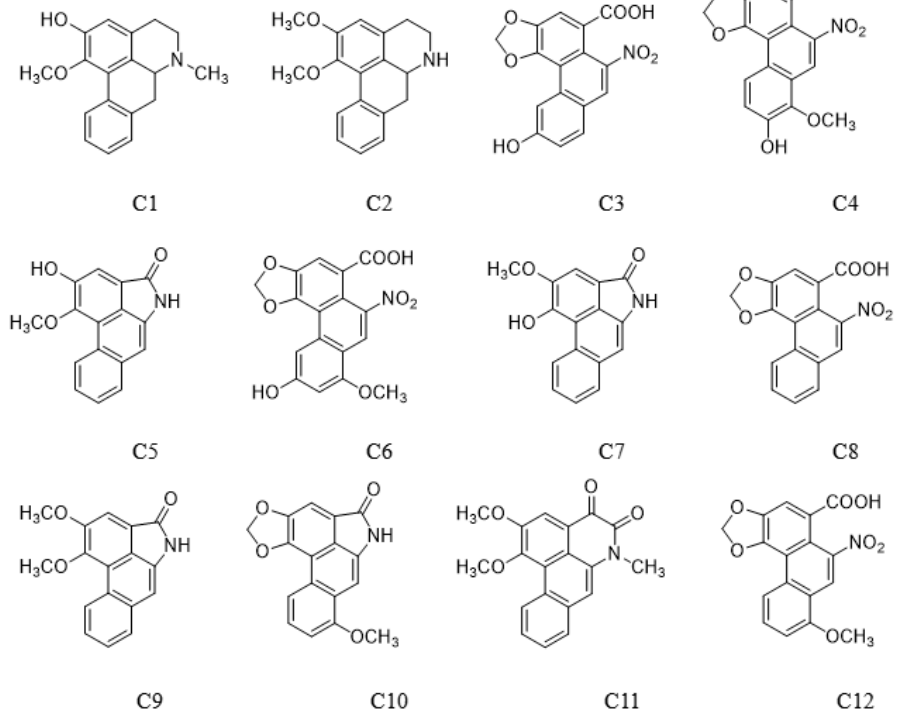
Table 3. Sample collection information for the present study.